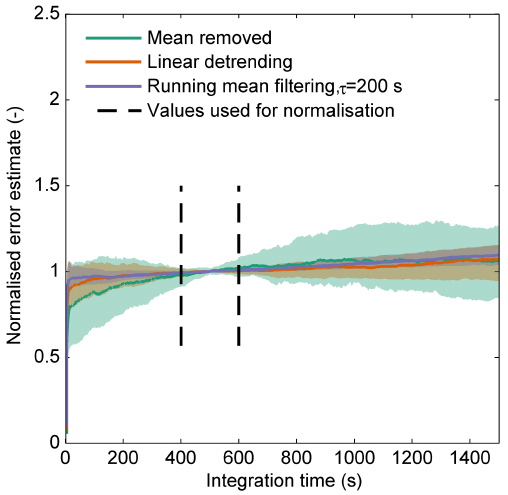
Figure 9. Normalised errors ˆ δ F,FS up to integration time 1500s. Estimated from time series with 2h (7200s) duration to avoid large uncertainties of the auto-covariance function at long lags. Normali- sation is done with the average between 400 and 600s. Lines show medians and the areas interquartile ranges around the medians. The time constant used in the high-pass filtered case is given in the plot. Sonic temperature data from the forest site were